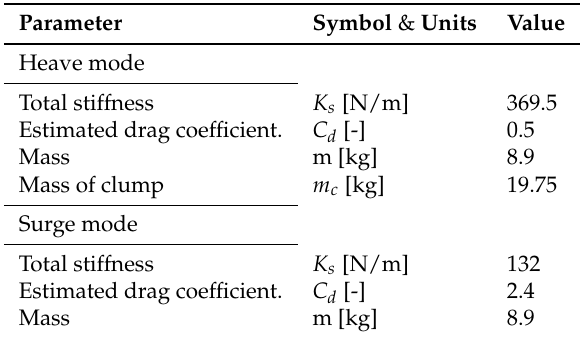
Table 2. Parameters (properties) for the time domain